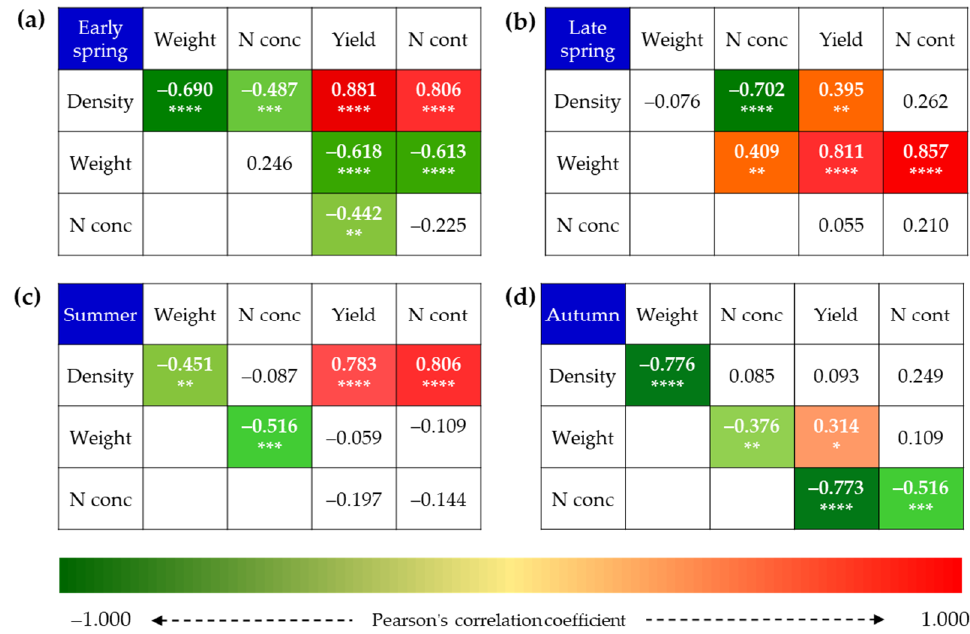
Figure 3. Pearson’s correlation coefficients among weight per shoot, shoot density, N concentration (N conc), N content (N cont), and yield ( n = 48) values in early spring ( a ), late spring ( b ), summer ( c ), and autumn ( d ). Red and green colors indicate significantly positive and negative correlations, respectively. Significance level: *, p < 0.05; **, p < 0.01; ***, p < 0.001; ****, p < 0.0001.